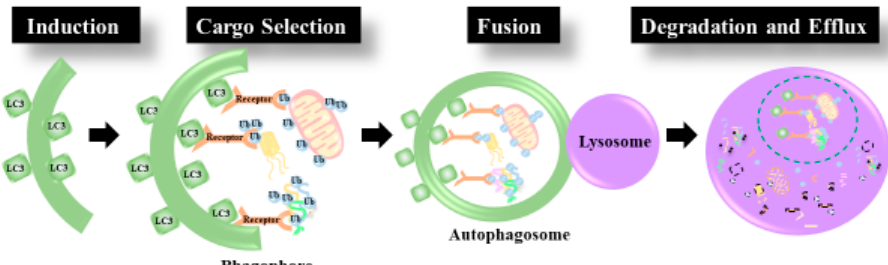
Figure 1. Autophagy Induction: first a pre-autophagosome (phagophore) is formed by the lipidation of LC3. Cargo Selection: Ubiquitinated cargo is tagged for degradation by autophagy receptors equipped with an LC3 binding motif and a ubiquitin binding domain. The Autophagosome is then elongated around the cargo to be degraded. Fusion: the mature autophagosome fuses with the lysosome. Degradation and e ffl ux: The contents of the autophagosome are degraded by proteolytic enzymes within the lysosomal lumen and nutrients are